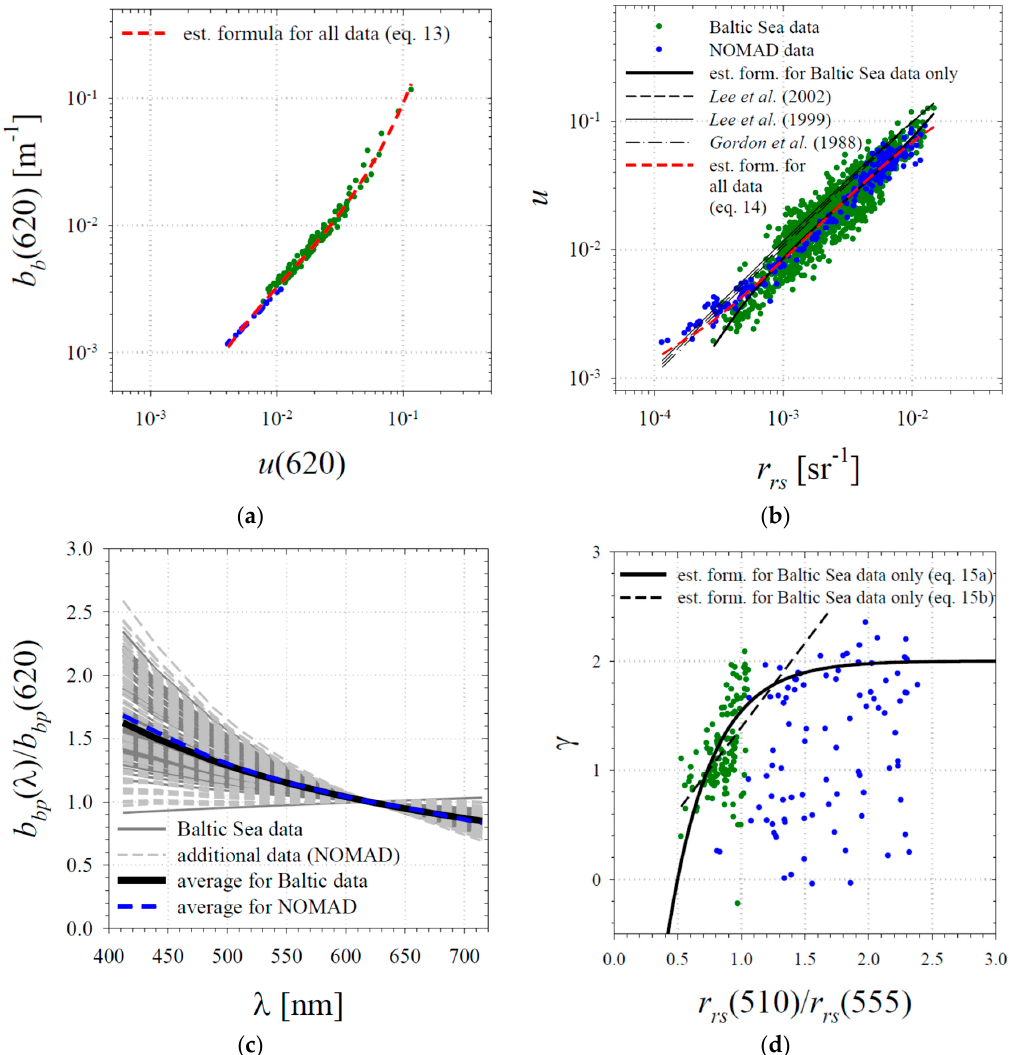
Figure 6. Selected relationships and estimated best-fit formulas: ( a ) the relationship between b b (620) and u (620); ( b ) the relationship between u and r rs ; ( c ) spectra of the normalized backscattering coefficient b b ( λ )/ b b (620); ( d ) the relationship between the slope of the b bp coefficient spectrum γ and the reflectance ratio r rs (510)/ r rs (555). In panel b, in addition to the line representing the best-fit relationships, selected formulas from the literature are also plotted (according to Lee et al. [5,44] and Gordon et al. [41]). Panel c shows spectra representing the average values of slope γ calculated for data from the Baltic Sea and from the NOMAD database.